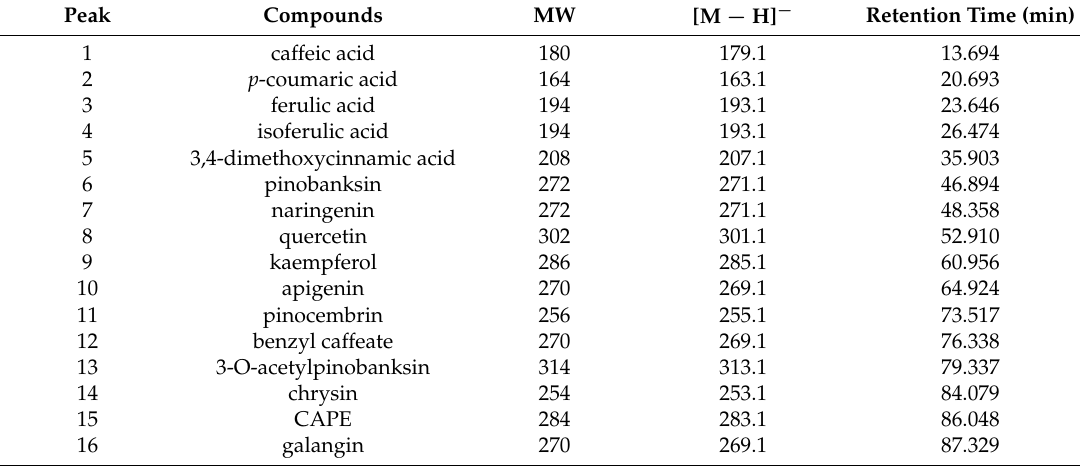
Table 2. Composition data for CBM propolis.